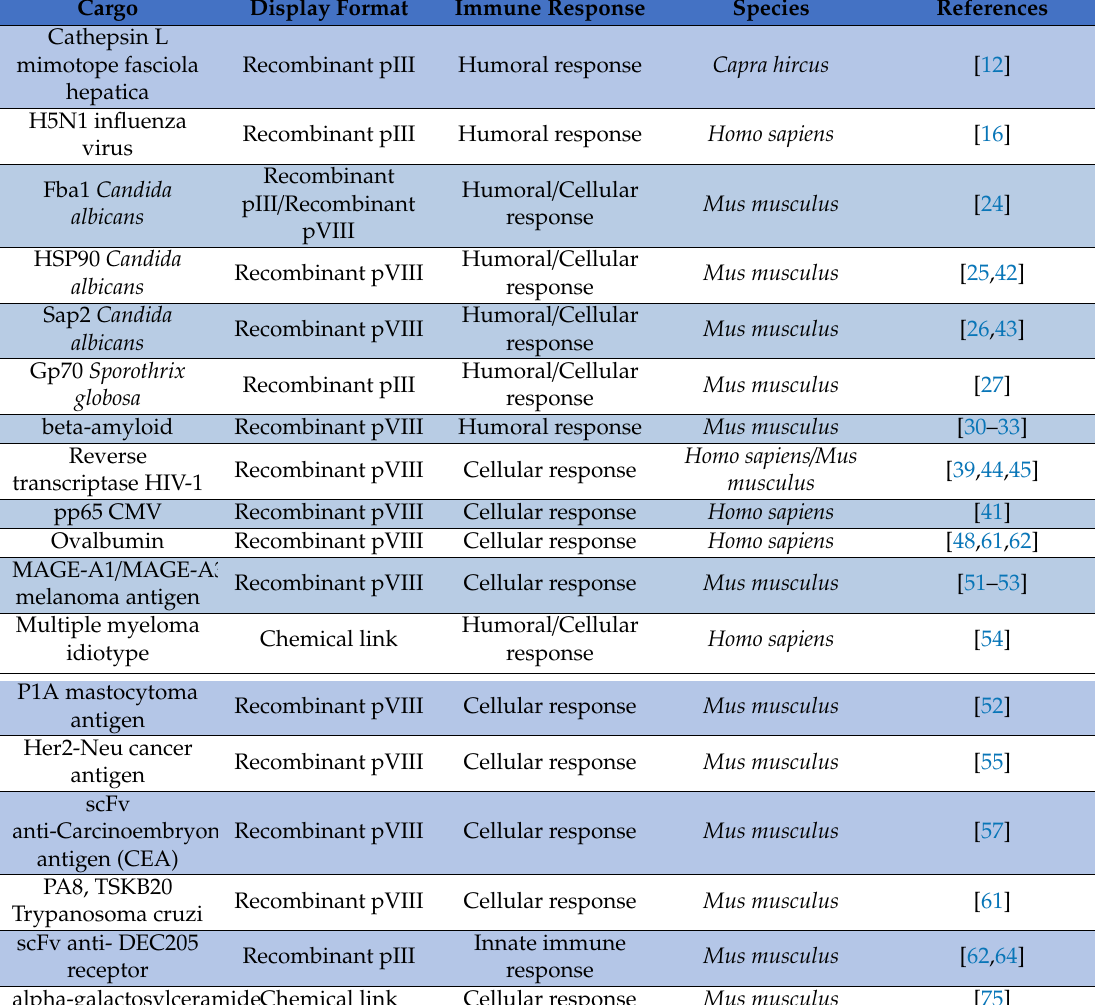
Table 3. Immunotherapeutic applications of filamentous